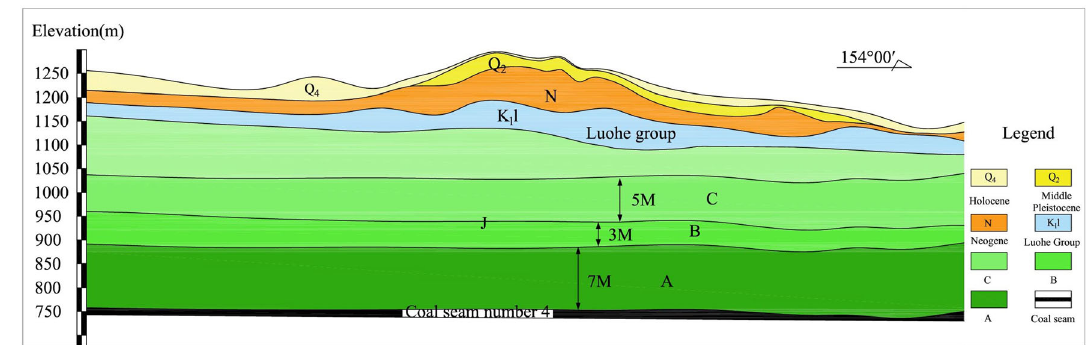
Fig. 3 Geological cross-section of study